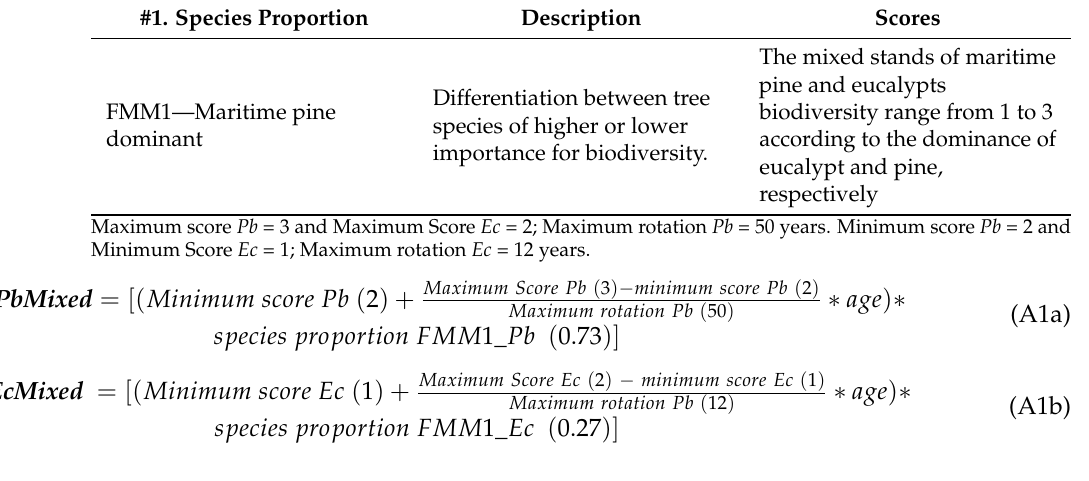
Table 2. Species proportion, description, minimum and maximum values used to define the FMM2 biodiversity score. #1. Species Proportion Description Scores The mixed stands of maritime pine and eucalypts Differentiation between tree biodiversity range from 1 to 3 FMM2—Eucalypt dominant species of higher or lower according to the dominance of importance for biodiversity. eucalypt and pine, respectively.